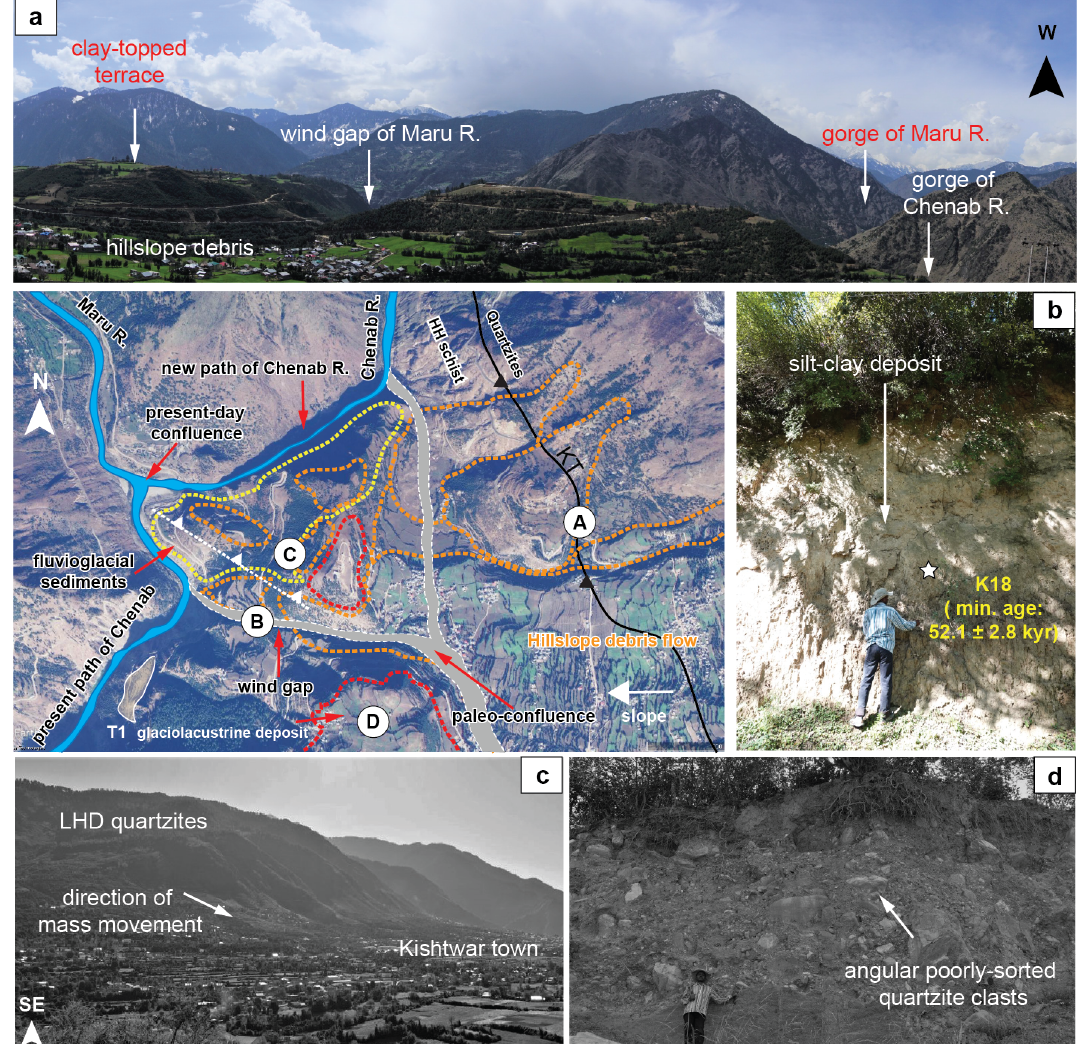
Figure 9. A Google Earth satellite image of northern Kishtwar showing the present-day flow path of the Chenab River (see Fig. 8 for location) (© Google Earth). Hillslope debris originated from the steep western margin of the KW (only made of massive white quartzites) and was deposited over fluvioglacial and glacio-lacustrine sediments and Higher Himalaya schist bedrock exposed below in the Kishtwar valley. Massive hillslope sediment flux impeded the paleo-drainage system, leaving behind the paleo-valley of the tributary, the Maru River. Our interpretation of the paleo-drainage is marked by a white dashed line. (a) A view of the Kishtwar surface from the western margin of the KW showing the present-day gorge of the Chenab River and its tributary. The wind gap (paleo-valley) of the tributary is visible. (b) A thick clay–silt deposit in the wind gap suggests abandonment of river flow. The OSL sample is saturated and hence only denotes the minimum age of valley abandonment and hillslope debris flow. (c) Overview picture of the frontal horses of the LH duplex and the direction of debris flow towards Kishtwar. (d) Angular, poorly sorted clasts and boulders were observed at the base of the debris flow unit near the village of Pochal, north of Kishtwar. The white quartzites of the LH are exposed in the vicinity of Kishtwar (see satellite image) – only the eastern valley flank could have collapsed in the